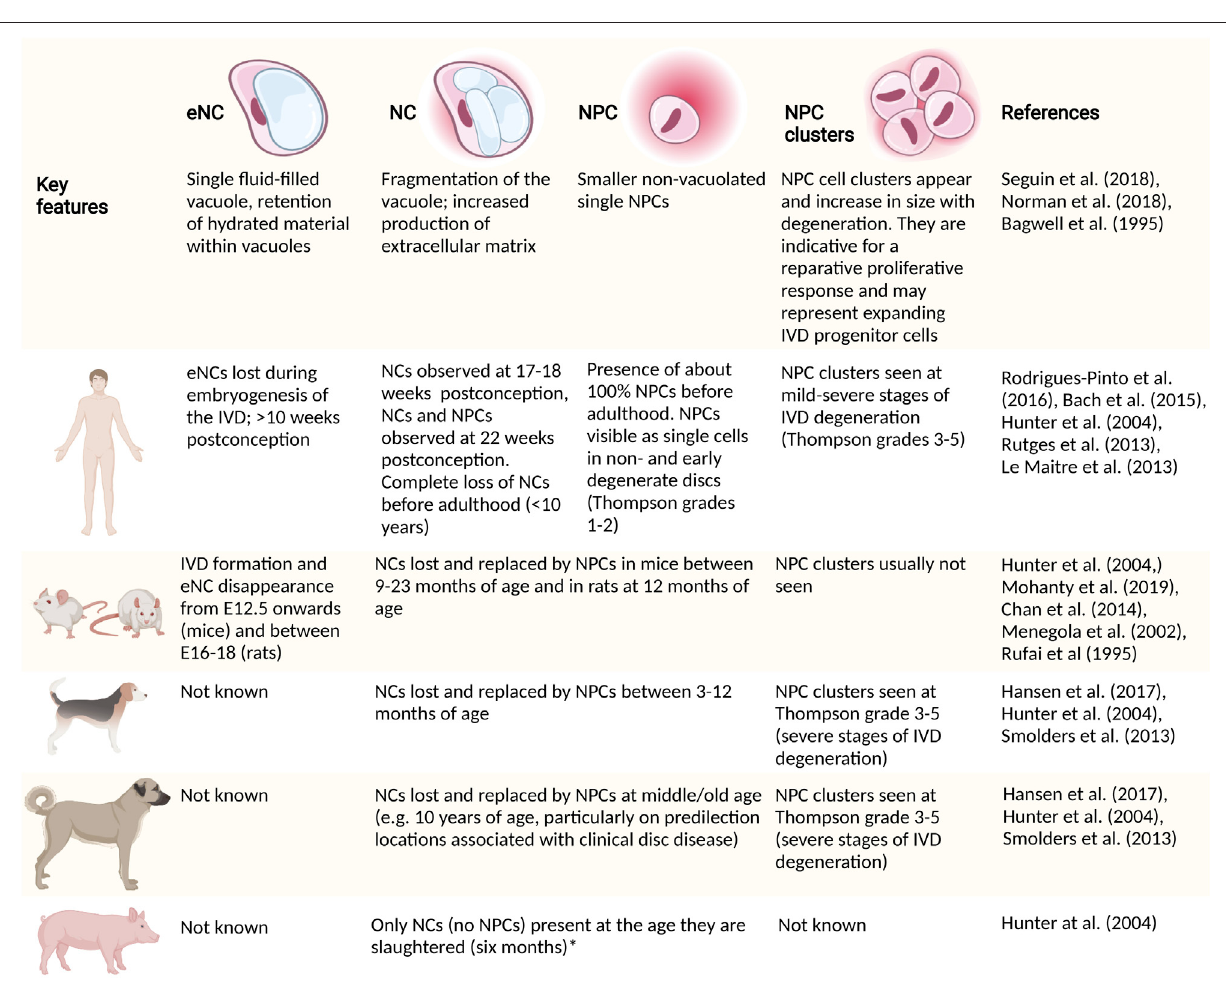
Frontiers in Cell and Developmental Biology |